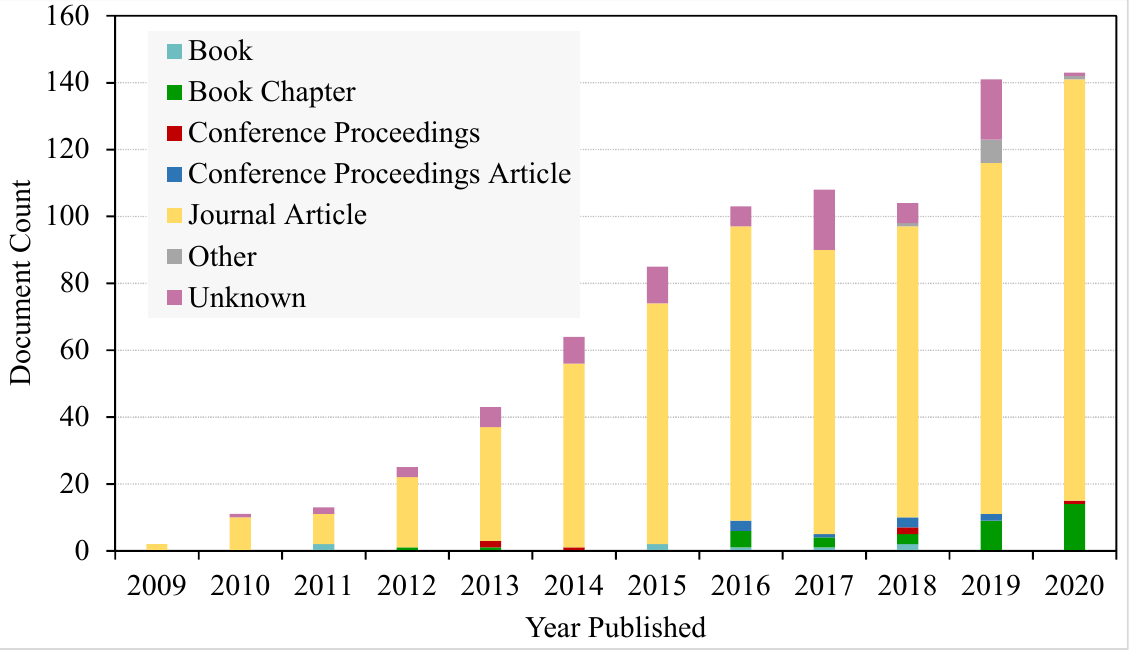
Figure 5. A chart of published manuscripts focusing on the functionalization of nanocellulose from Lens.org.